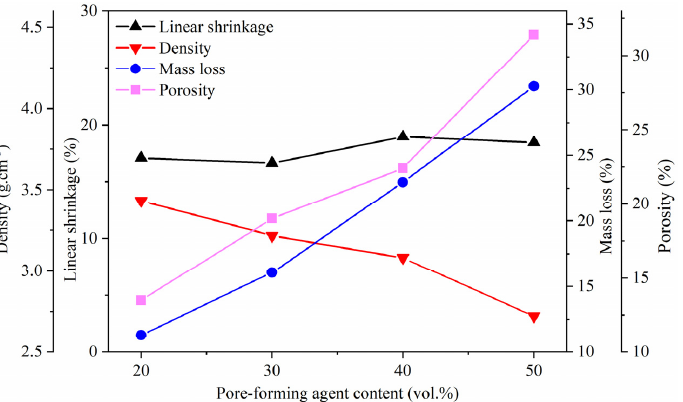
Figure 3. Density, linear shrinkage, mass loss, and porosity of porous alumina with different quantities of the pore-forming agent, sintered at 1550